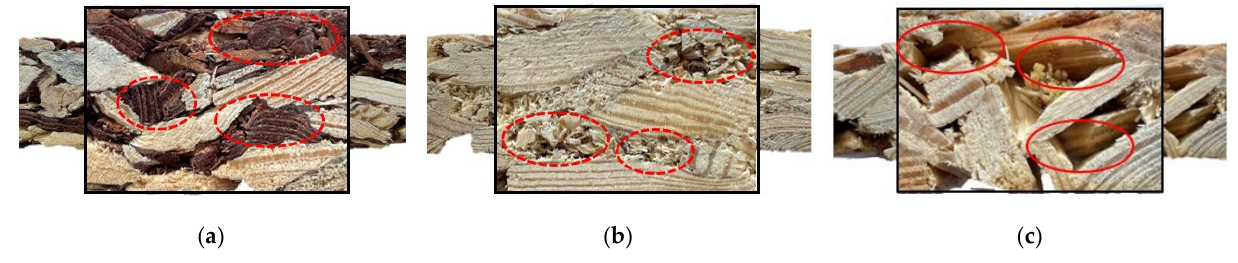
Figure 4. Cross ‐ sections of the boards: ( a ) with bark particles (variant A); ( b ) with sawdust (variant D); ( c ) only with wood chips (variant E) (dashed circles indicate filled spaces; solid circles indicate void spaces) .